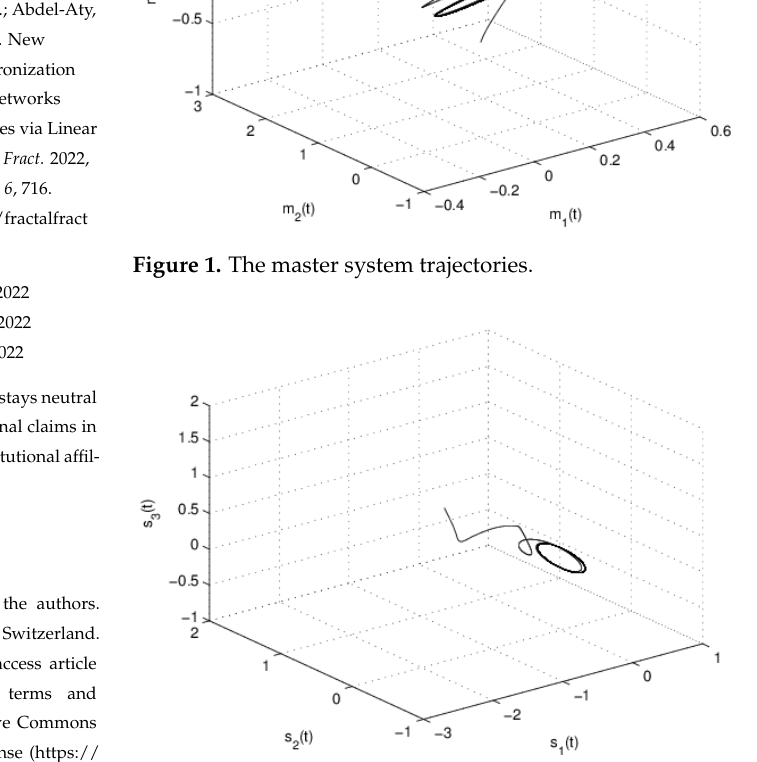
Figure 2. The slave system trajectories.